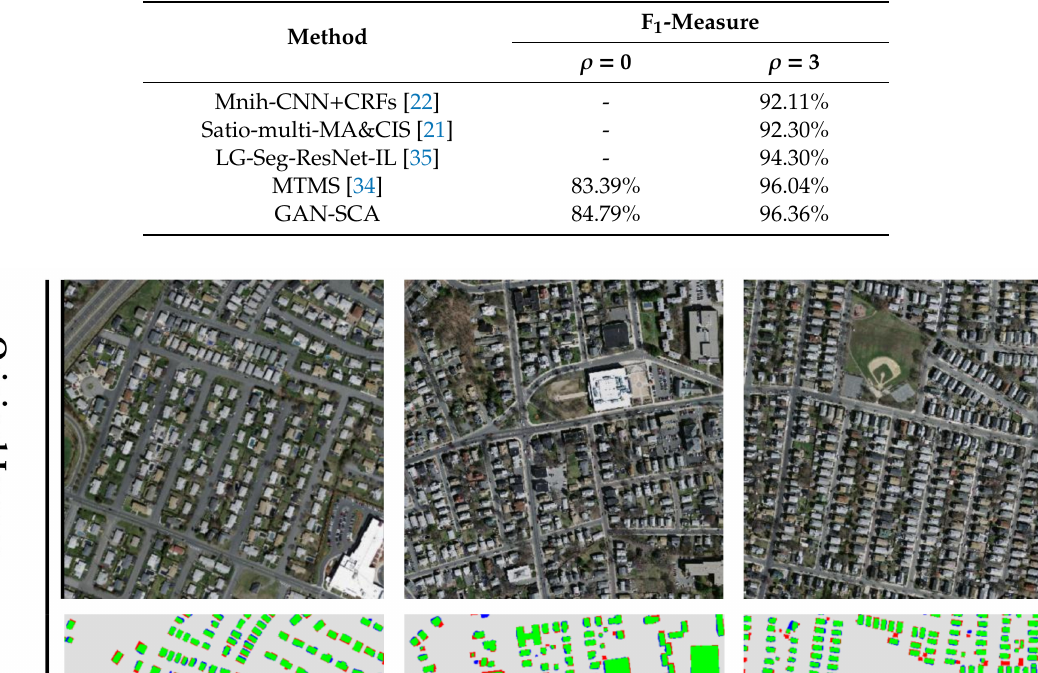
Table 3. Experimental results on Massachusetts buildings dataset.